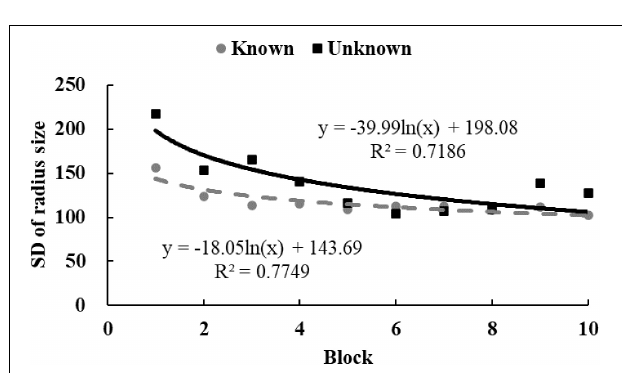
FIGURE 6 | The SD of radii size in Study 2. The solid and dotted lines represent the regression curves for the unknown and known conditions,